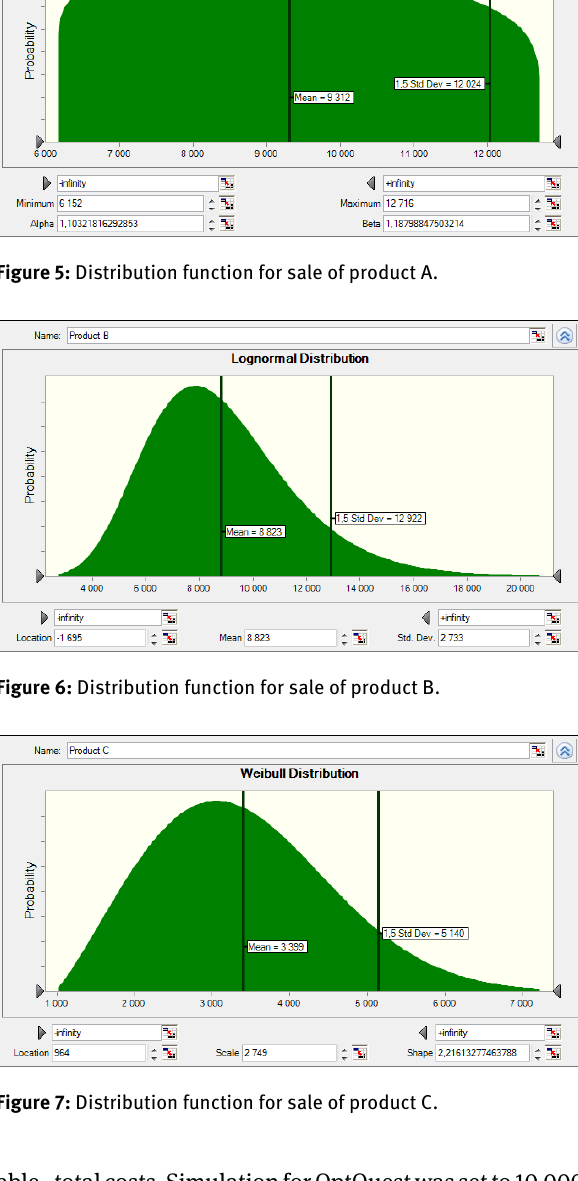
weibull division. Figure 5-7 present distribution functions for product sales including 1.5 standard deviation.